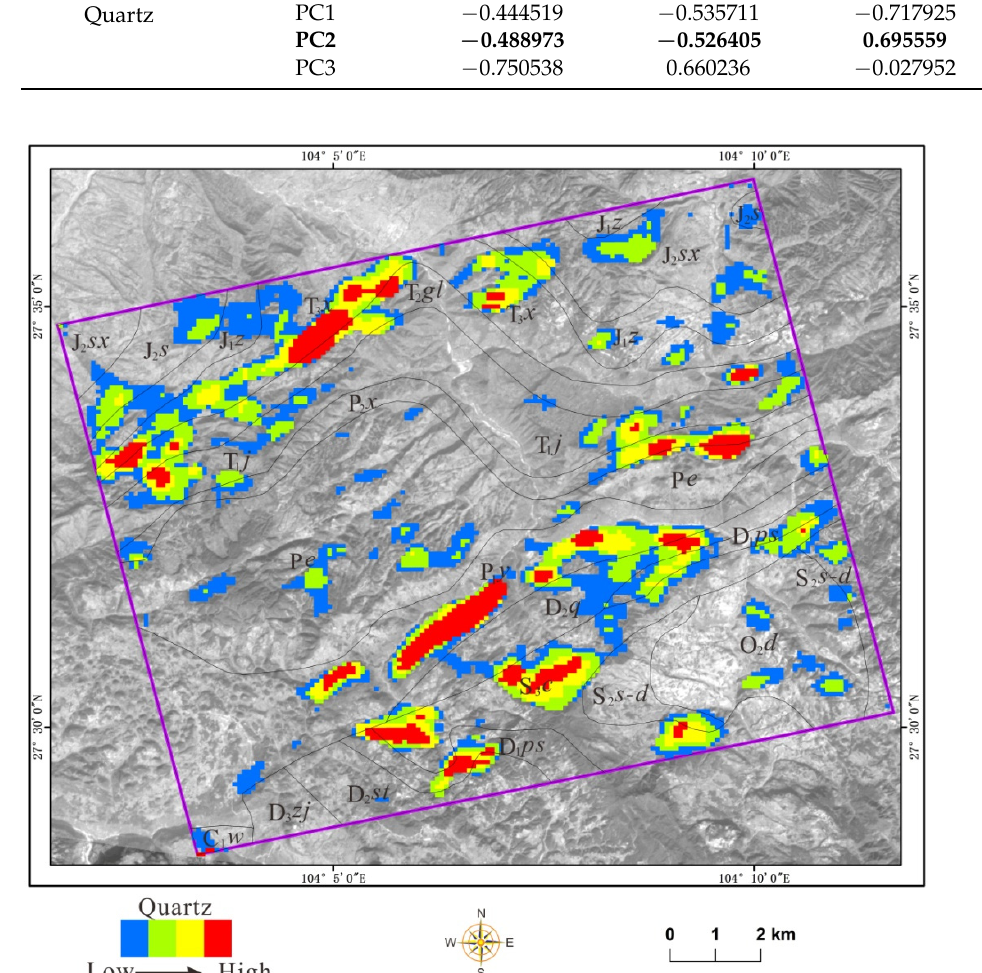
Figure 5. Quartz mapped with ASTER data using the SPCA method.